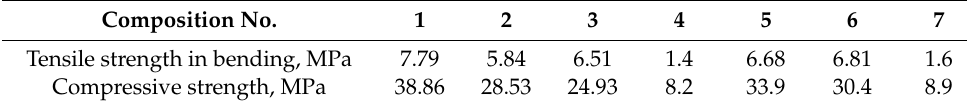
Table 3. Compressive strength and tensile strength in bending. Composition No.